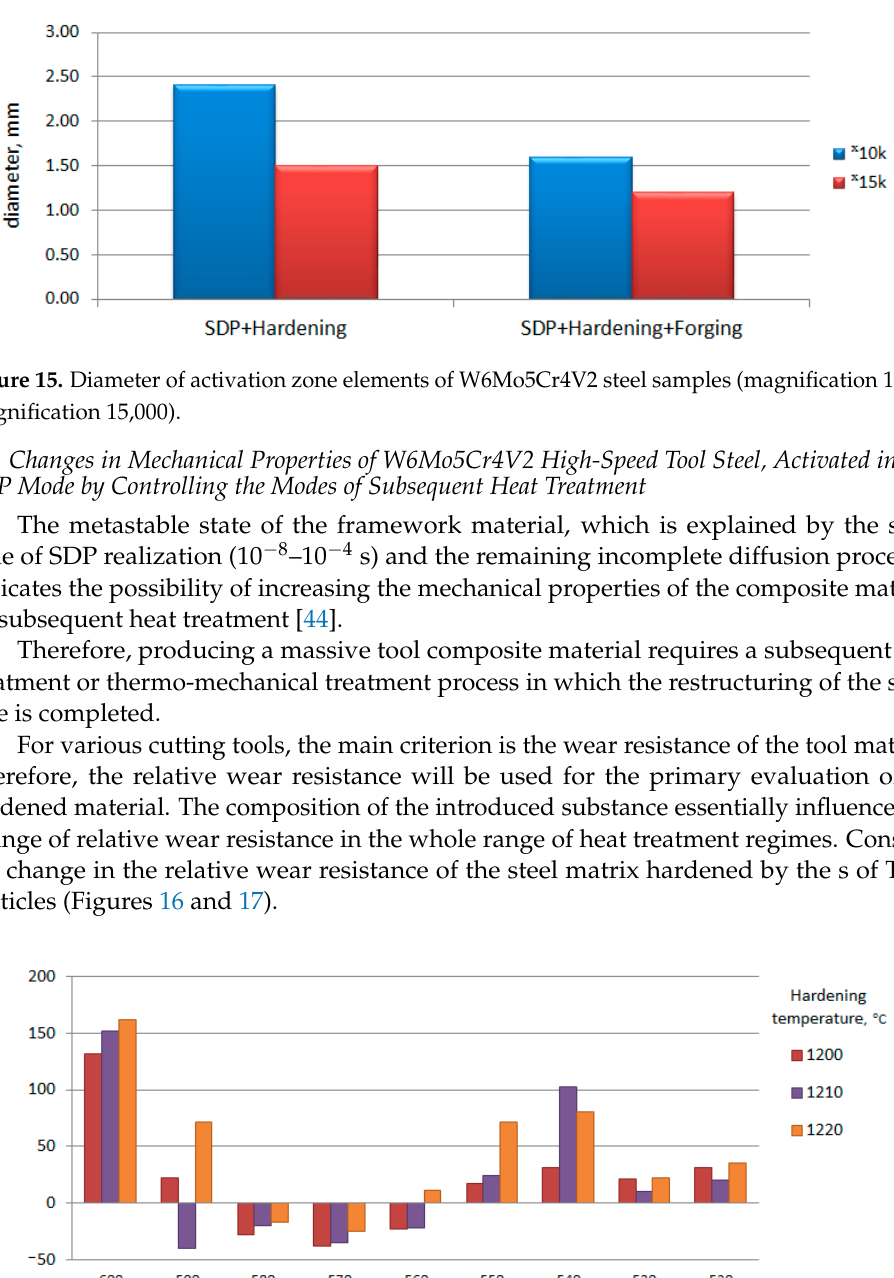
Figure 14. Activated zone area of treated samples of W6Mo5Cr4V2 steel excluding the influence of